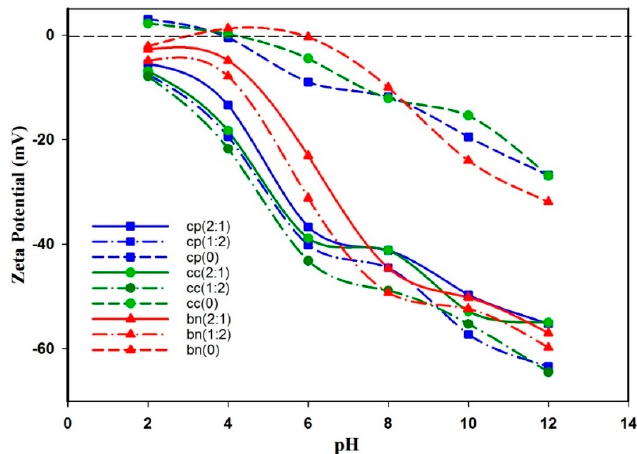
Figure 3. Zeta potentials of chalcopyrite, chalcocite and bornite in a mixed collector (SIBX:BBT) system as a function of pH. cp-chalcopyrite, cc-chalcocite, bn-bornite.